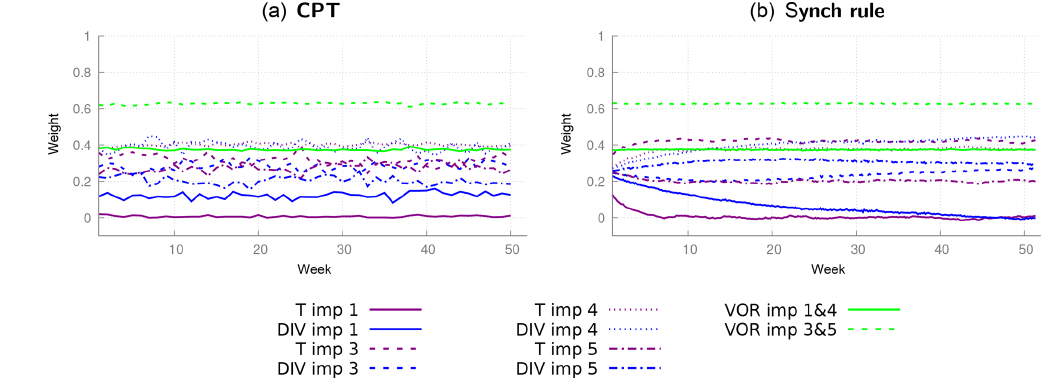
Figure 11. CPT weights calculated during a training period of 1 week for 1 year (a) and the weights for the synch rule for a training period of 1 year (b) with four imperfect models.